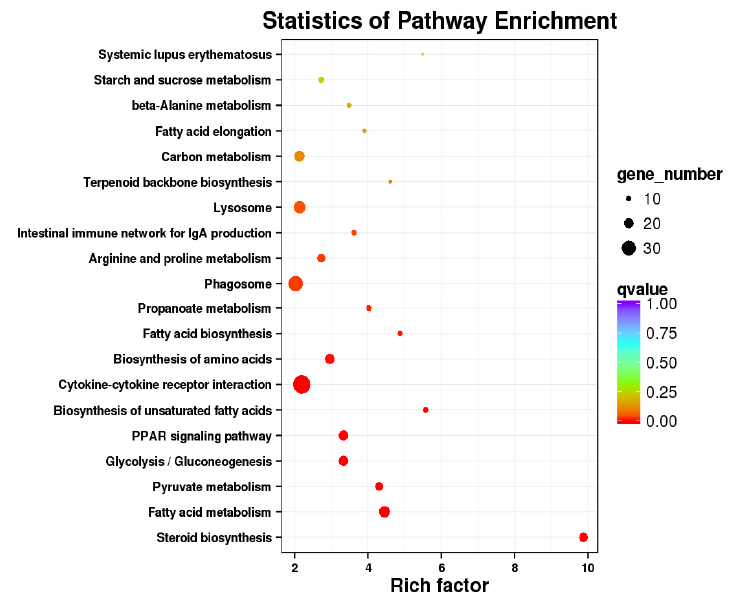
Figure 6. Scatterplot of the top 20 most enriched A. schrenckii KEGG pathways. Note: The abscissa shows the enriched element in each pathway, and the ordinate represents the number of routes.